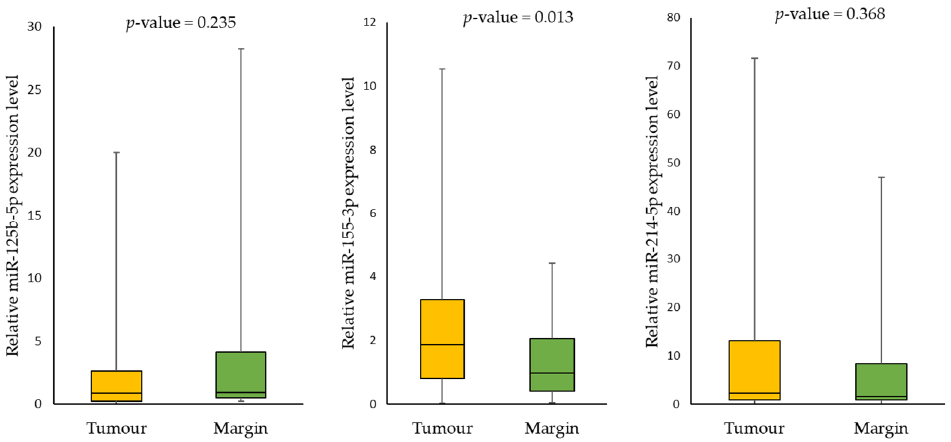
Figure 2. The relative expression levels of tested miRNAs in tumour samples compared to margin